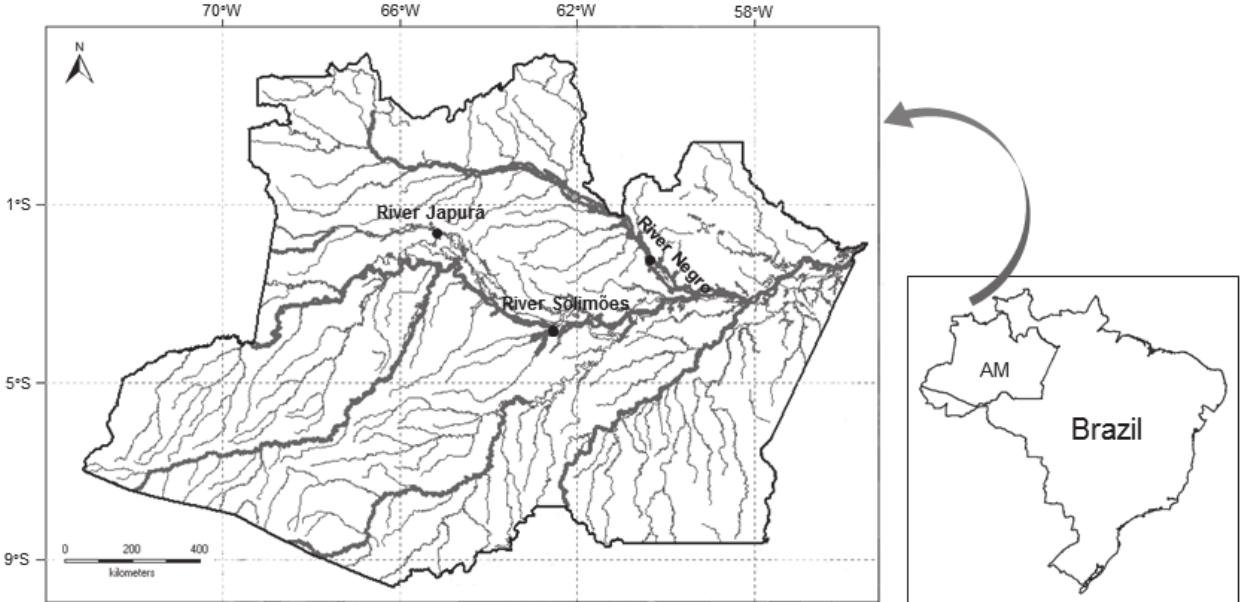
Fig. 1. Partial map of the Amazon basin showing the study area where Prochilodus nigricans were collected. Rivers: Soli- mões, Japurá and Negro,